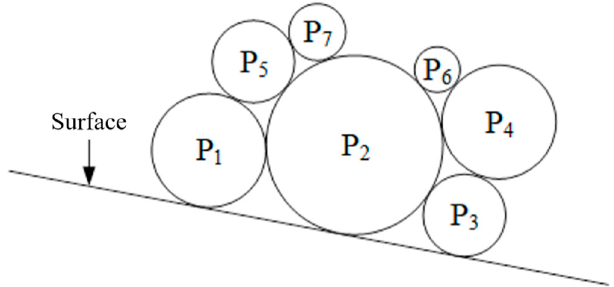
Figure 7. Particle-to-particle contact and particle-to-surface contact.